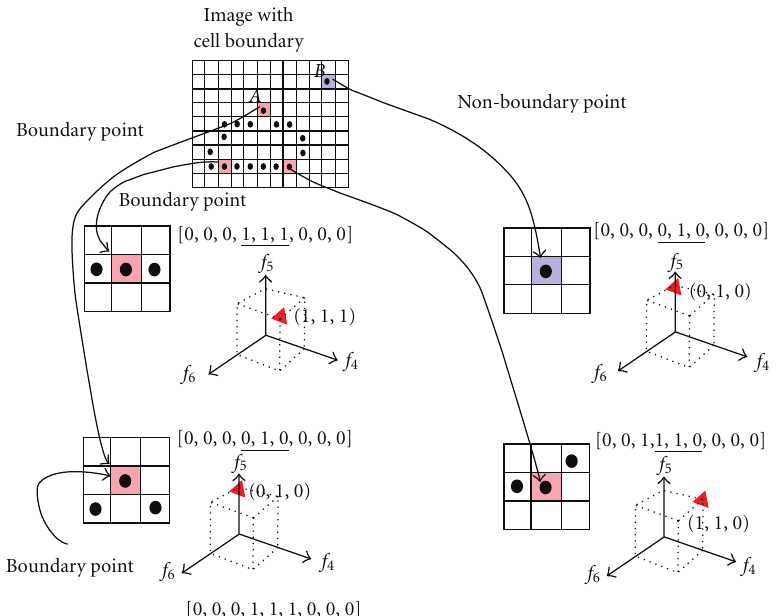
Figure 4: Mapping of neighbourhoods of points into the components of a 9-element feature vector, [ f 1 , f 2 , ... , f 9 ]. Four candidate points are considered, three corresponding to true boundary points, and one corresponding to an isolated noise pixel ( B ) that has an intensity similar to those of the boundary points. Note that if we plot where the points in a three-dimensional subspace of 9-dimensional space lie (red triangles), we find that pixels A and B fall in the same place in the three dimensional subspace formed by components f 4 , f 5 , and f 6 ; this means that this subspace cannot be su ffi cient to classify pixels correctly. Creating a feature vector containing all 8 neighbouring pixels’ intensities, and that of the candidate pixel, provides a much better chance of successfully teaching an SVM to recognise boundary pixels from non-boundary pixels, but even this is not su ffi cient for low signal-to-noise conditions (see text for